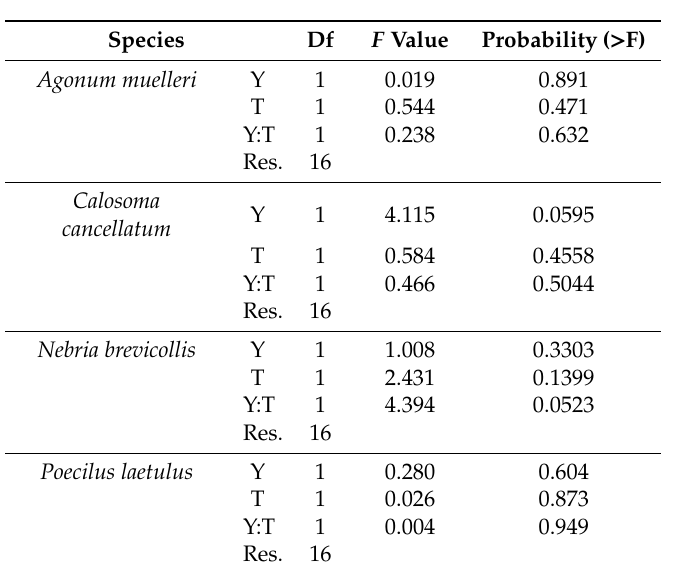
Table 4. Results of the BACI analysis with factors ‘year’ (Y) and ‘tillage regime’ (T) for each common carabid